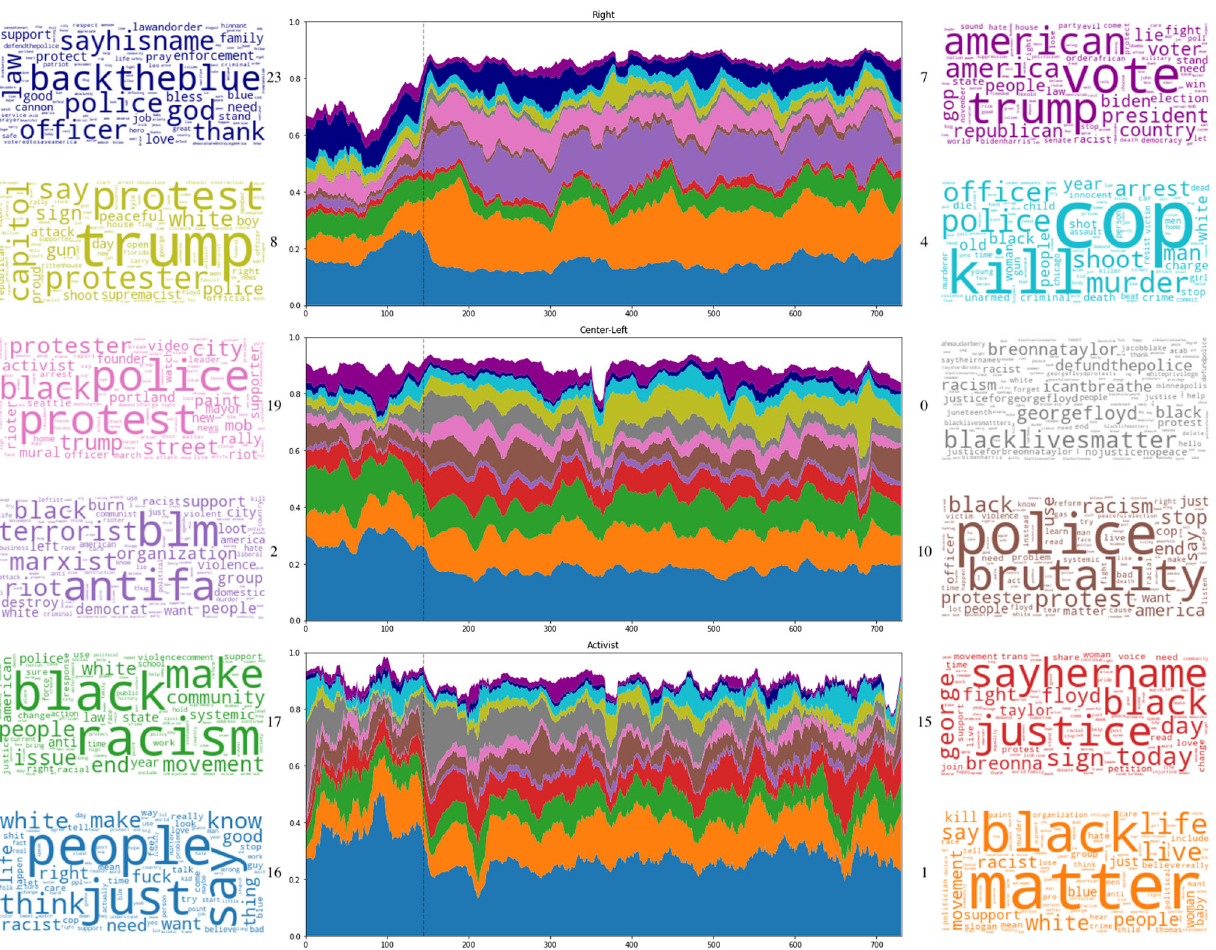
Fig. 5 Proportion of tweets in each cluster with a maximum loading on each of the top 12 topics. Colors correspond to wordclouds representing each topic; topic number is next to each word cloud. Vertical line is date of George Floyd ’ s murder. Timeseries for each topic smoothed using a 15-day linear Savitzky-Golay fi lter (Savitzky and Golay, 1964).